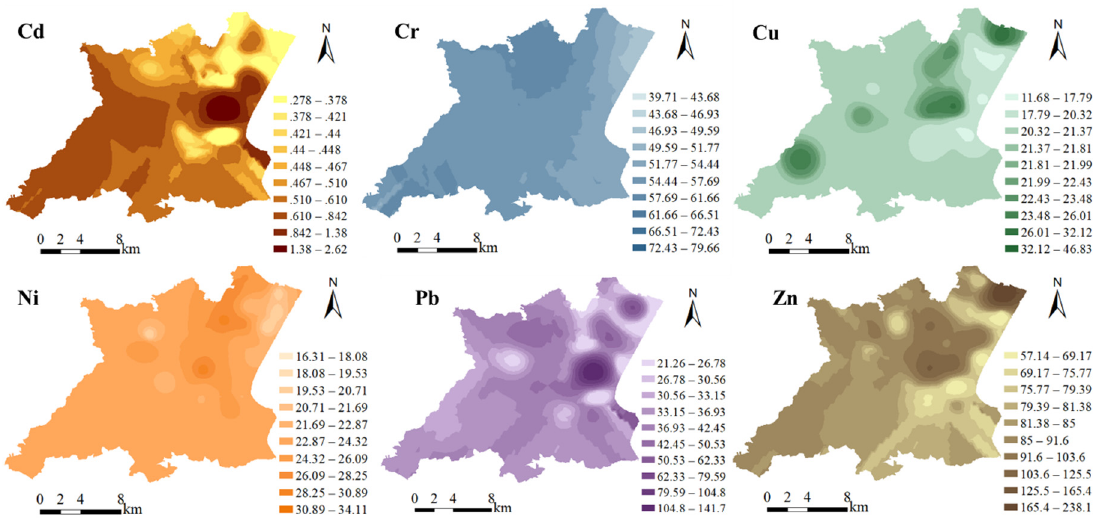
Figure 2. Spatial distributions of Cd, Cr, Cu, Ni, Pb, and Zn concentrations (mg/kg) in the study area. The spatial distributions of elements were determined with the kriging interpolation method.